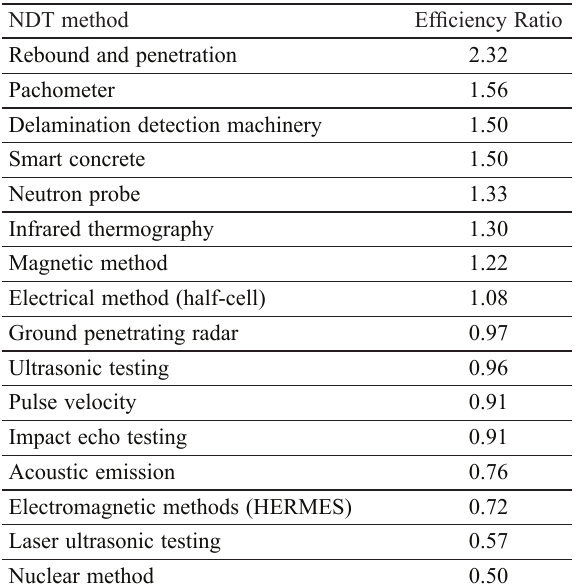
Table 14. Efficiency ratio of concrete NDT methods Table 15. Efficiency ratio of steel NDT